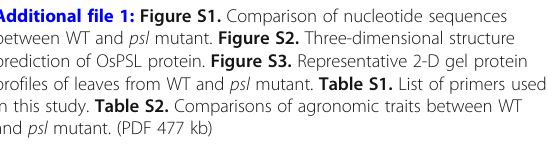
Additional file 1: Figure S1. Comparison of nucleotide sequences between WT and psl mutant. Figure S2. Three-dimensional structure prediction of OsPSL protein. Figure S3. Representative 2-D gel protein profiles of leaves from WT and psl mutant. Table S1. List of primers used in this study. Table S2. Comparisons of agronomic traits between WT and psl mutant. (PDF 477